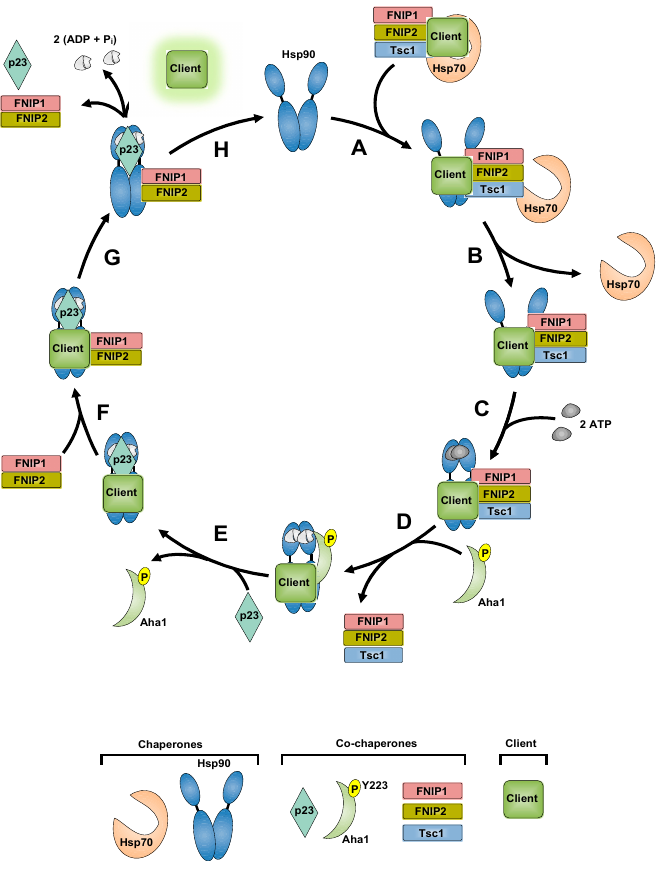
Figure 4 . FNIPs and Tsc1 in the Hsp90 chaperone cycle. ( A ) FNIPs and Tsc1 co-chaperones scaffold a client from Hsp70 to Hsp90. ( B ) Hsp70 dissociates from the complex. ( C ) ATP binding triggers Hsp90 conformational rearrangements resulting in the ‘closed’ conformation. ( D ) Aha1 phosphorylated at Y223 displaces FNIPs/Tsc1 co-chaperones from the Hsp90 complex and promotes ATP hydrolysis to ADP + Pi. ( E ) p23 binds and stabilizes the closed conformation of Hsp90. ( F ) FNIP co-chaperones bind to the Hsp90:client:p23 complex to promote client maturation. ( G ) The complex dissociates releasing the mature client. ( H ) Hsp90 is reset to begin another cycle.